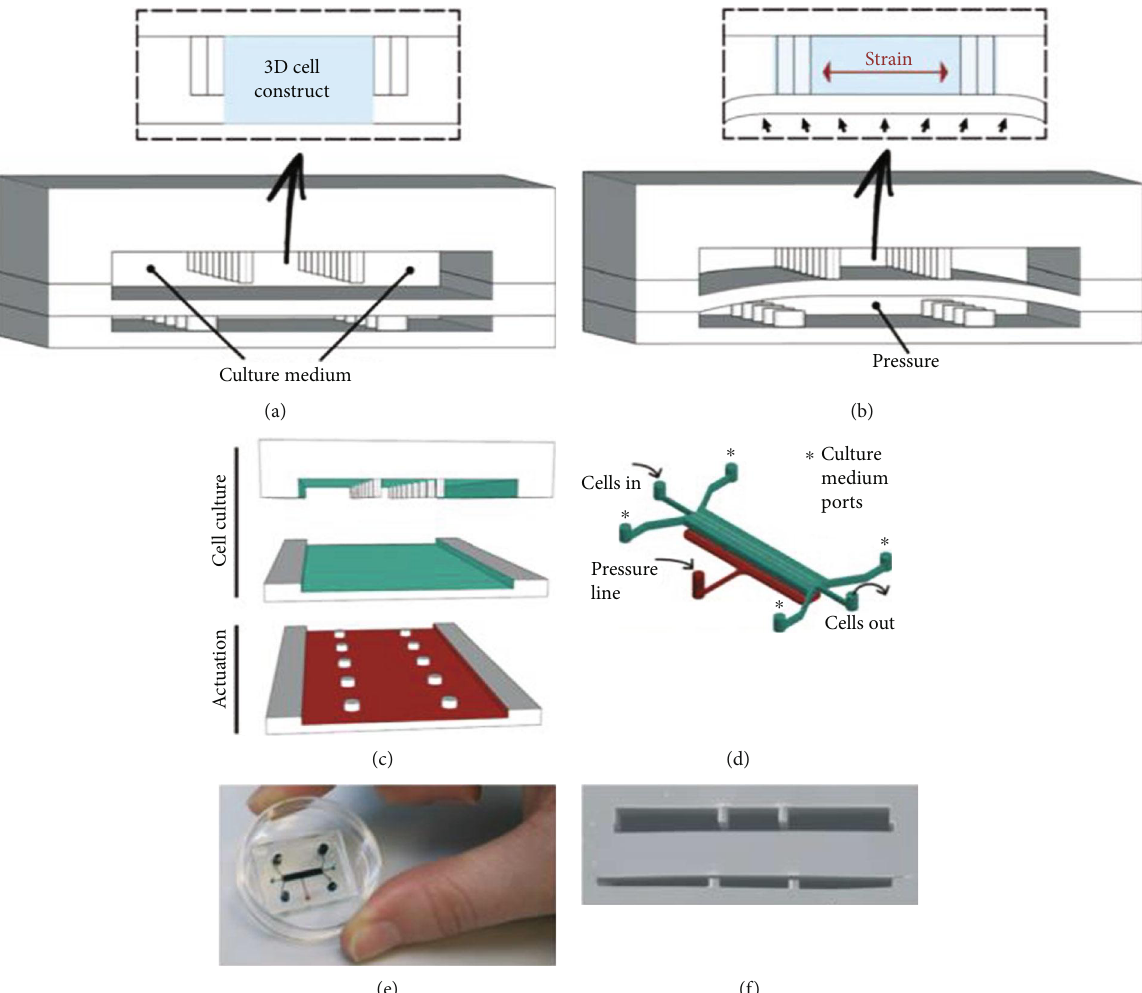
Figure 18: Design of the 3D heart-on-a-chip microdevice. (a) The device uses two compartmentalized PDMS chambers. (b) By pressurizing the bottom compartment, the compression transduces into a uniaxial strain applied to the 3D cell construct. (c) Inside view of the PDMS chambers. (d) 3D sketch of both compartments. (e) Picture of an actual 3D heart-on-chip device. (f) Scanning electron microscopy image of a cross-section of the device (scale bar, 500 μ m). Reproduced (or adapted) with permission [101], ©2016, Royal Society of Chemistry.